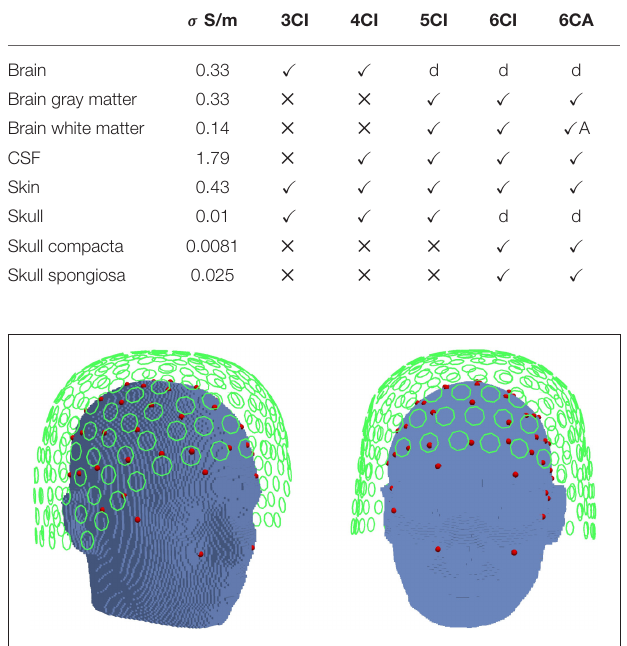
FIGURE 1 | Position of the EEG electrodes (red spheres) and MEG gradiometers (green circle) in relation to the head. Only the first coil of each MEG gradiometer is